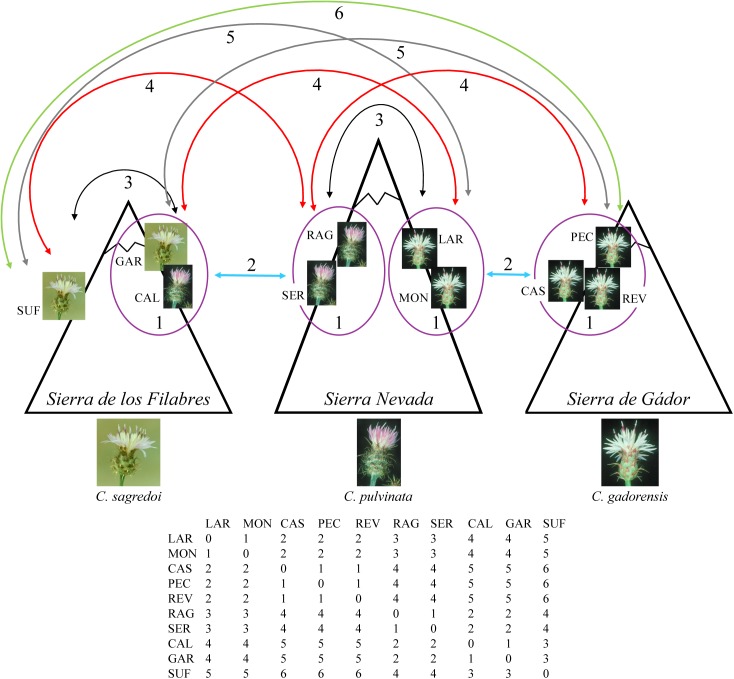
Diagram and matrix for the distance classes used in the spatial autocorrelation analysis. Class 1: intramountain-intramountainside (populations in the same mountain range, same mountainside; surrounded by a purple circle on the diagram and 1 in the matrix); class 2: intermountain-same valley (populations in two nearby mountains, on mountainsides facing the same valley; blue arrows on the diagram and 2 in the matrix); class 3: intramountain-intermountainside (populations in the same mountain range, different mountainsides; black arrows on the diagram and 3 in the matrix); class 4: intermountain-different valley (populations in two nearby mountains, on mountainsides facing different valleys; red arrows on the diagram and 4 in the matrix); class 5: one-mountain in between (populations in two mountains with one mountain in between; gray arrows on the diagram and 5 in the matrix); class 6: two-mountain in between (populations in two mountains with two mountains in between; green arrow on the diagram and 6 in the matrix).